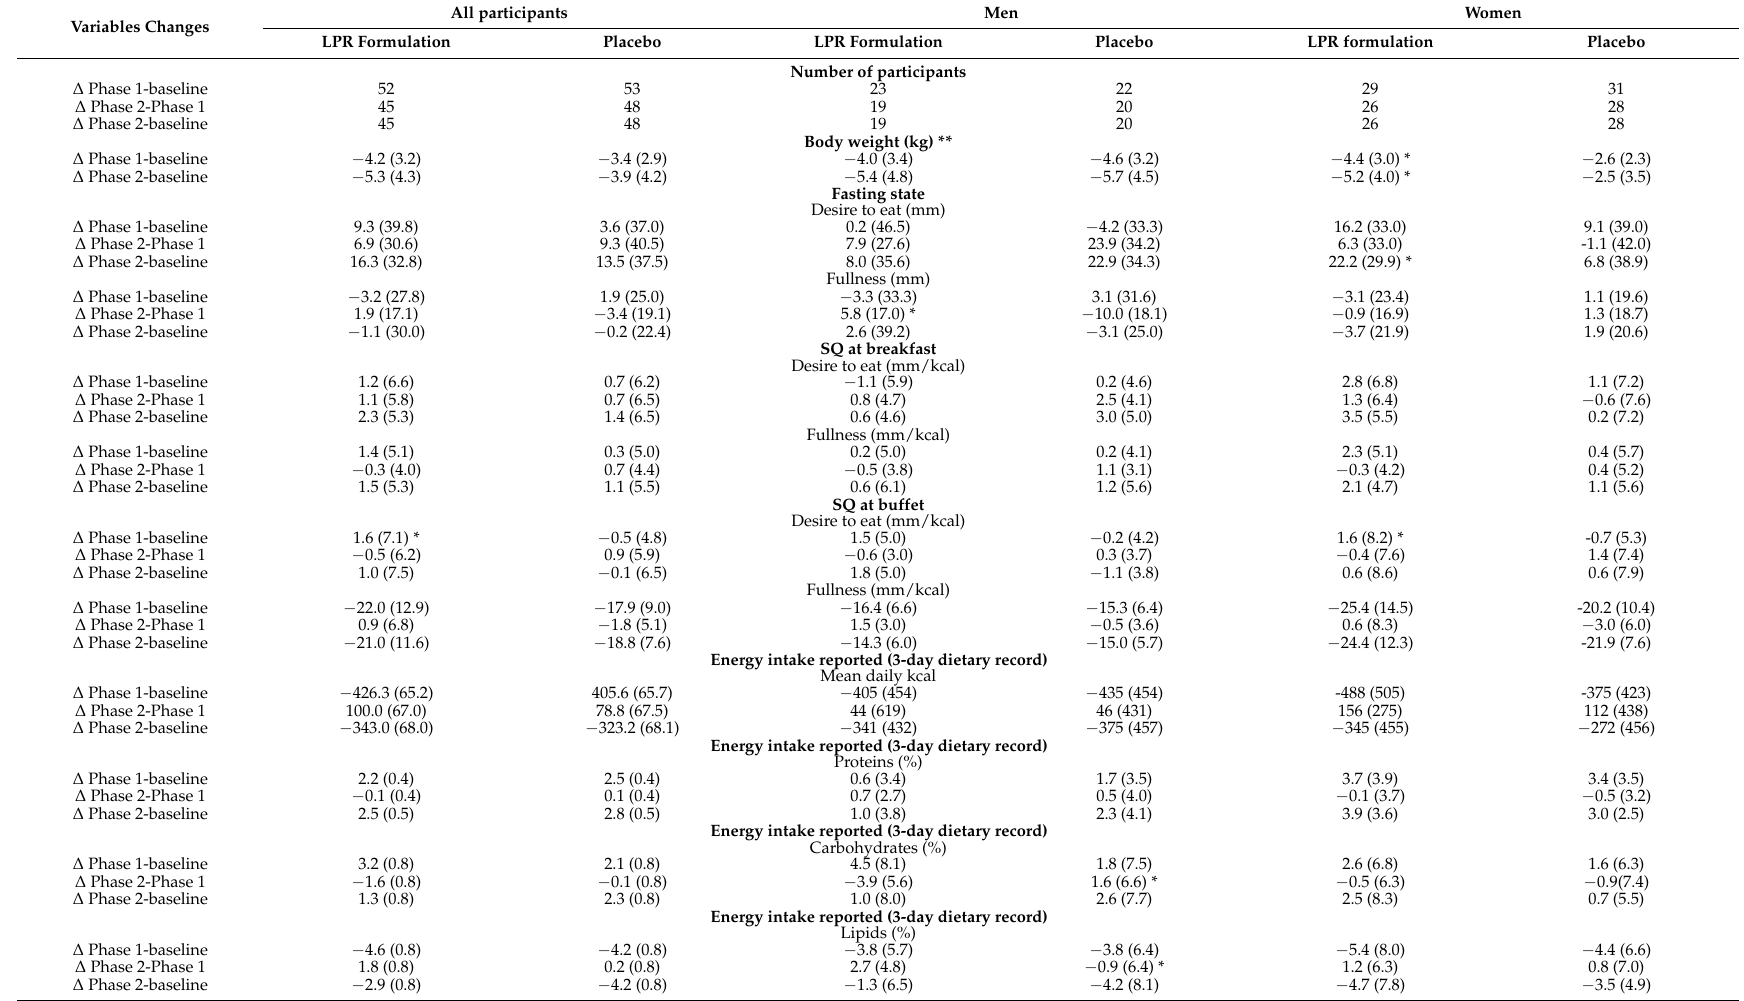
Table 2. Changes in body weight, appetite sensations, and energy intake during the